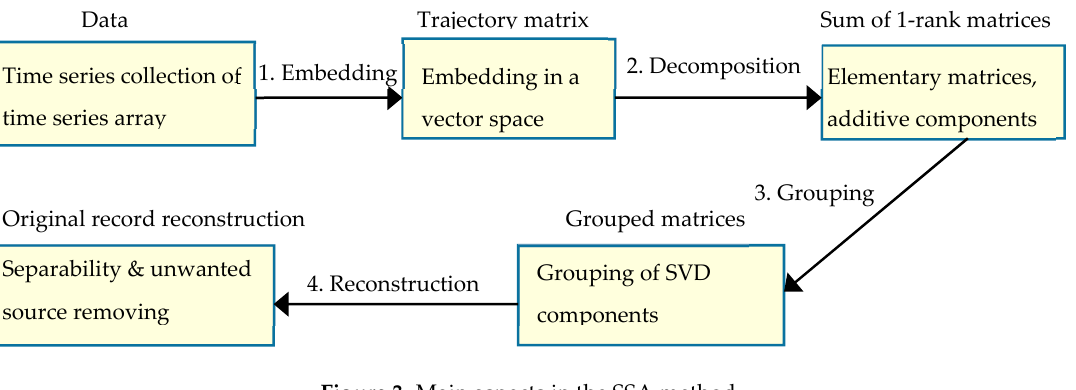
Figure 3. Main aspects in the SSA method.